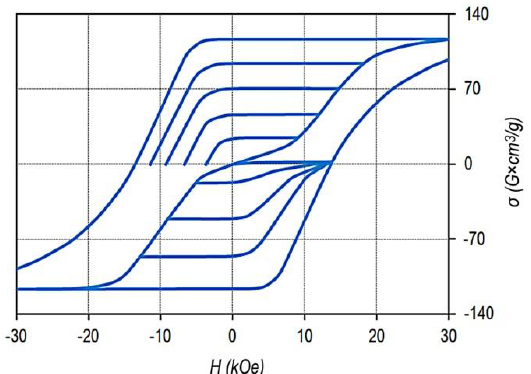
Figure 1. Major and minor hysteresis loops of pseudo-single crystal Sm 0.87 Zr 0.13 (Co 0.60 Cu 0.070 Fe 0.240 ) 6.5 sample in the high-coercivity state; (bottom) and (top) curves correspond to the magnetization curves of the sample demagnetized by reverse field and alternating filed, respectively (VSM, without allowance for the demagnetizing factor, N =